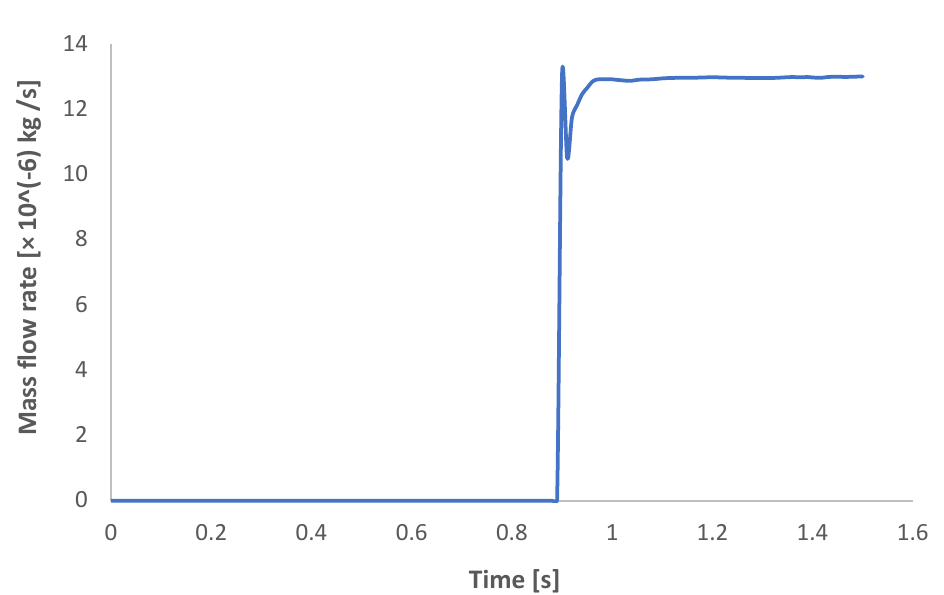
Figure 13. PLA mass flow rate from material melting simulation.